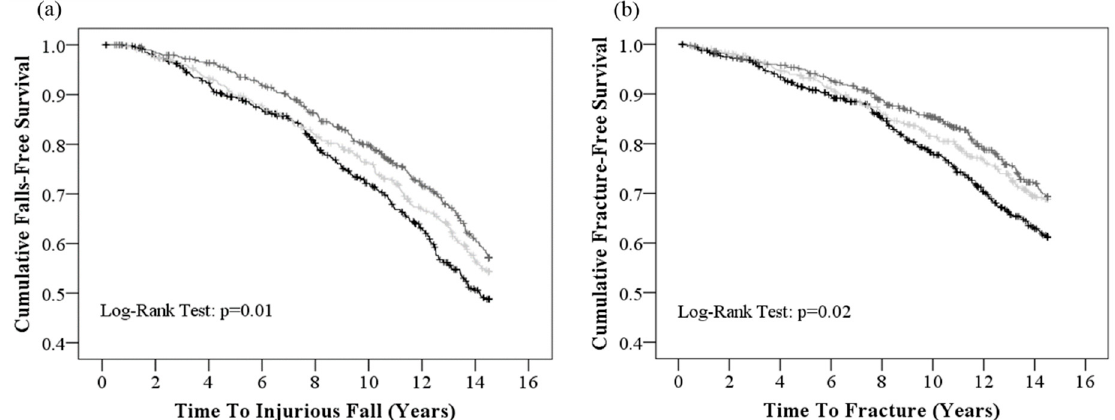
Figure 1. Kaplan-Meier survival curves for vegetable diversity categories for ( a ) injurious falls and ( b ) fractures over 14.5 years. Low ( ≤ 3 number/d), moderate (4 number/d), and high ( ≥ 5 number/d) vegetable diversity categories are represented by the black, light grey, and grey lines, respectively.